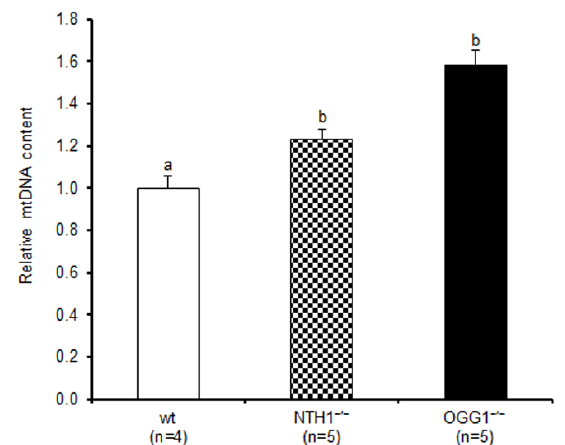
Figure 1. Relative mitochondrial DNA (mtDNA) content in liver from wild-type (wt), endonuclease III homolog knockout (NTH1 − / − ), and mitochondrial isoform of 8-oxoG DNA glycosylase / apurinic